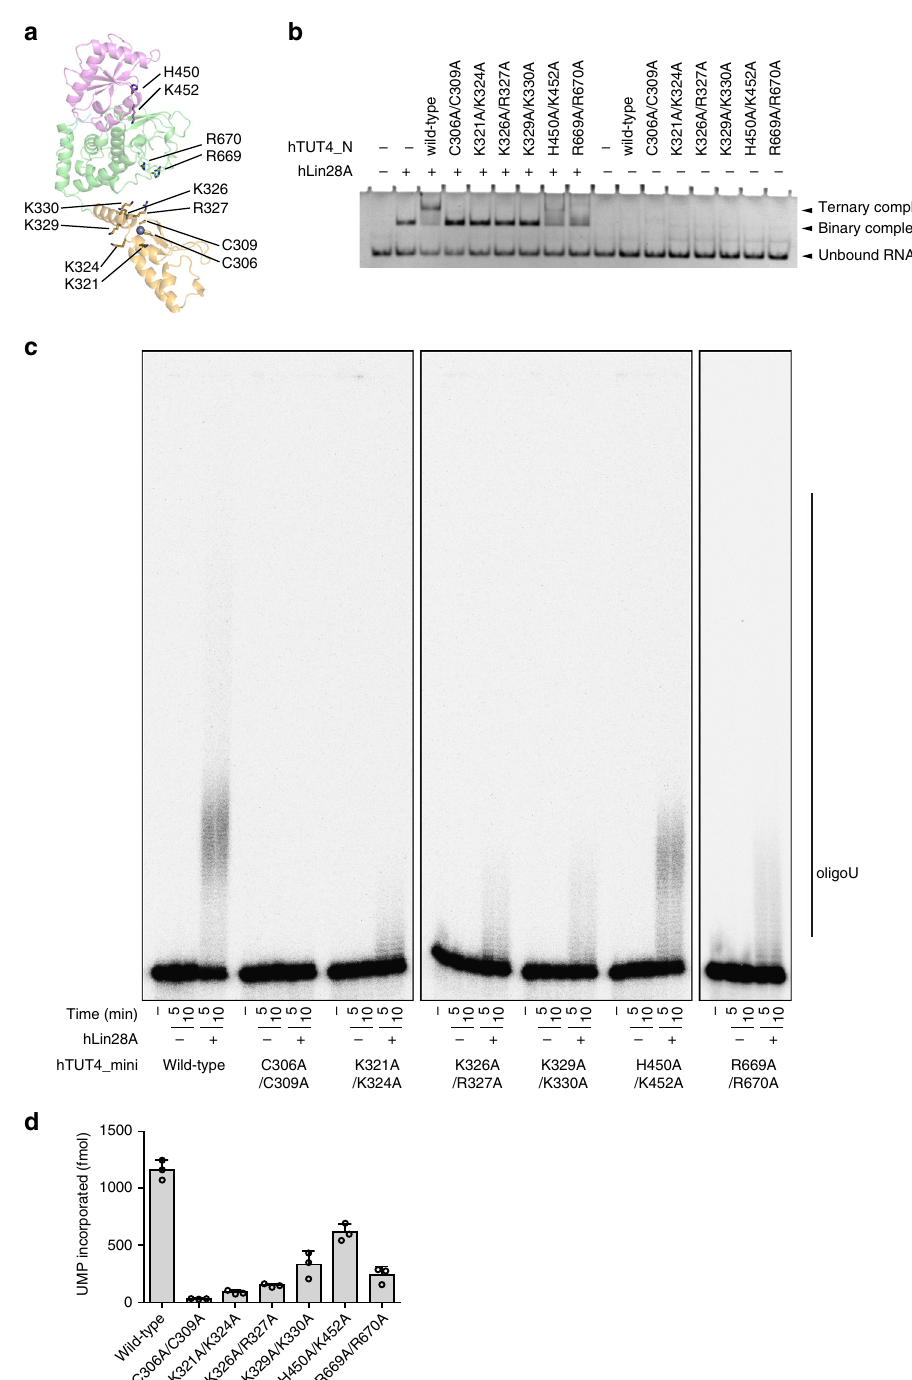
Fig. 4 Uridylylation of pre-let-7 by human TUT4 variants. a The residues mutated in the LIM for the biochemical analyses in b and c . b Electrophoretic mobility shift of pre-let-7a-1 by wild-type or mutant hTUT4_N proteins, in the presence or absence of hLin28A. The samples were separated by 10% (w/v) polyacrylamide electrophoresis under native conditions, and the gel was stained with ethidium bromide. Experiments were performed three times, and a representative image is shown. c In vitro uridylylations of [ 32 P]-labeled pre-let-7a-1 by wild-type or mutant hTUT4_mini proteins, in the presence or absence of hLin28A. The reaction products were separated by 10% (w/v) polyacrylamide gel electrophoresis under denaturing conditions. d Quanti fi cation of α -[ 32 P]-UTP incorporation into pre-let-7a-1 by wild-type or mutant hTUT4_mini proteins in the presence of hLin28A, after a 5 min reaction (Supplementary Fig. 6). The bars in the graph are the means ± SD of three independent the presence of the ZKs of hLin28A and hTUT4_N (Supplemen- tary Fig. 7). The protection/de-protection pattern changes observed in region 6 suggest that the ZKs of hLin28A and